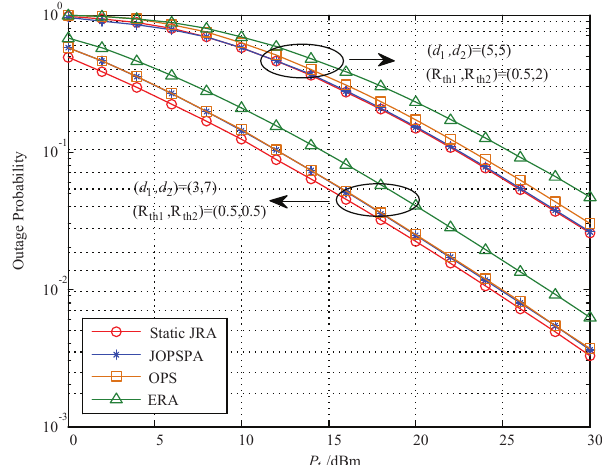
Figure 5. Outage probability vs. P t based on statistic CSI. OPS—optimal power splitting.